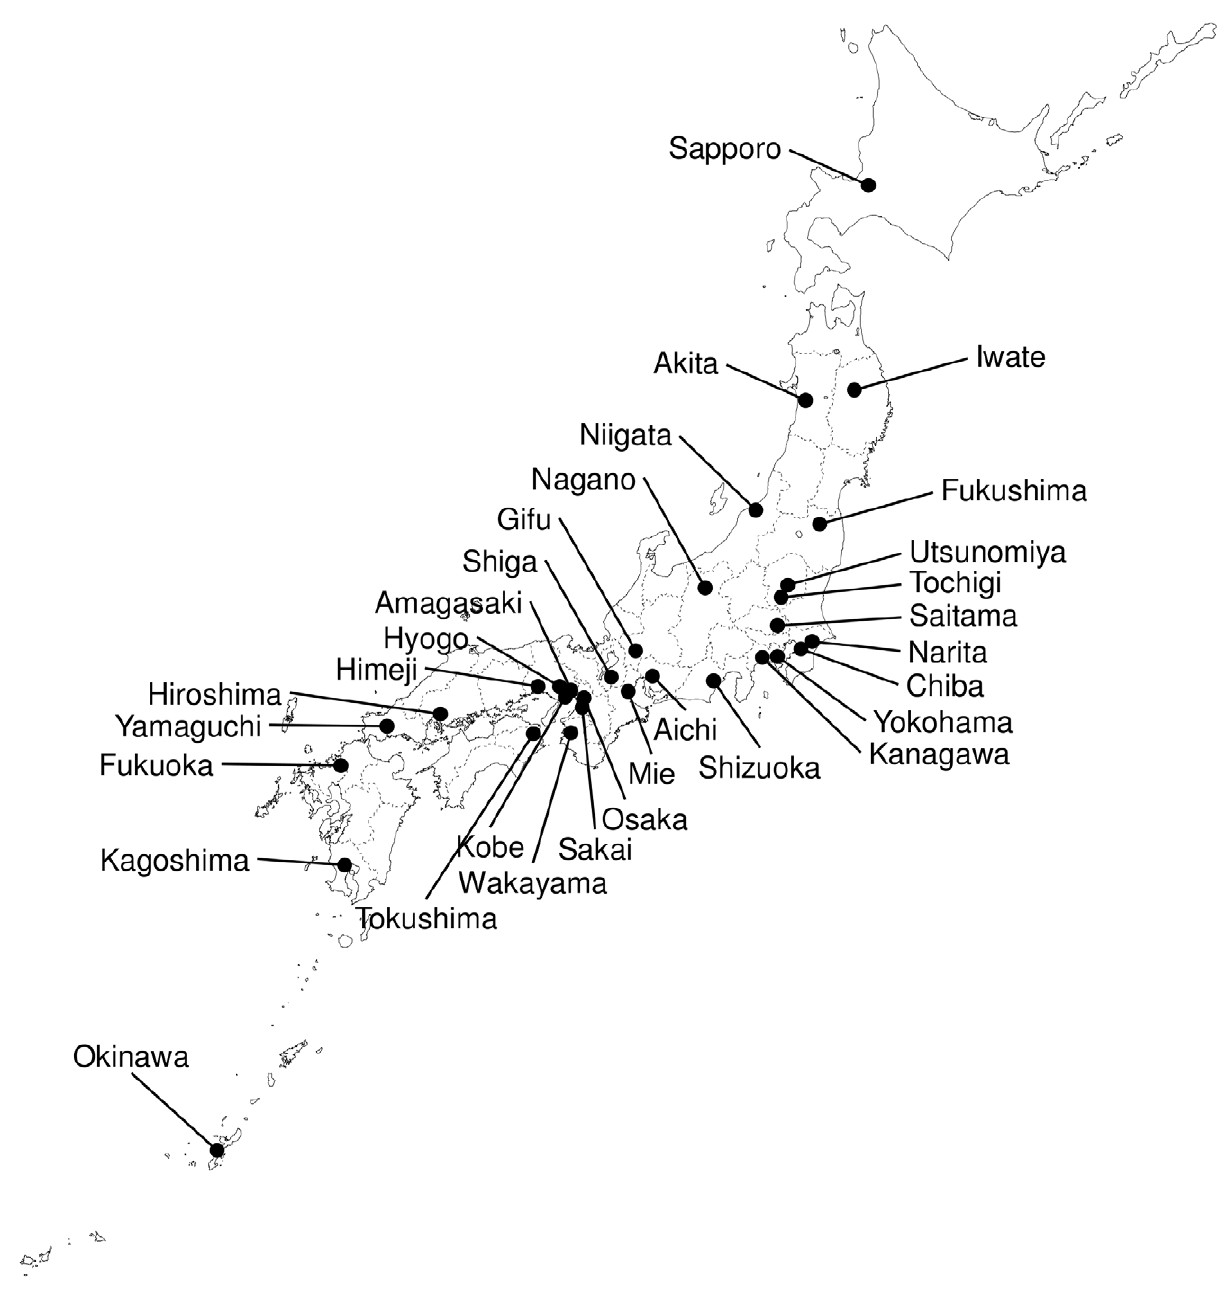
Figure 1. Geographical distribution of virus isolates of influenza A(H1N1)pdm in Japan. doi:10.1371/journal.pone.0011057.g001 clade. Fifty nine of the 75 strains isolated in Japan were separated into the 12 micro-clades in the full-length phylogeny (Figure 2 and S1). Mean evolutionary diversity within micro-clades was 0.00083, whereas inter-micro-clade diversity was 0.001 (Table S2).